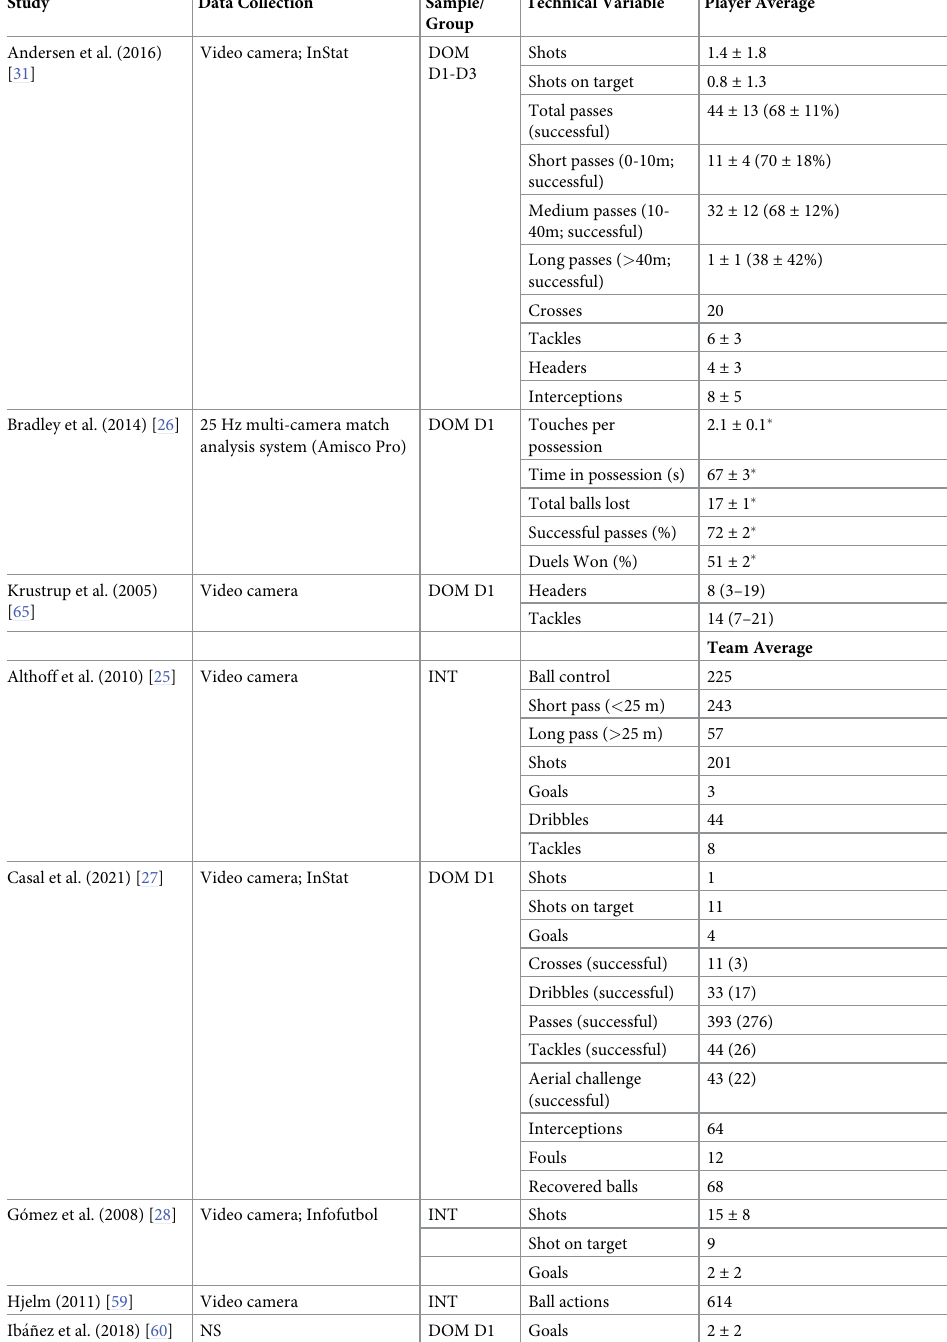
Table 9. Whole-match technical characteristics of women’s soccer match-play, presented as player or team